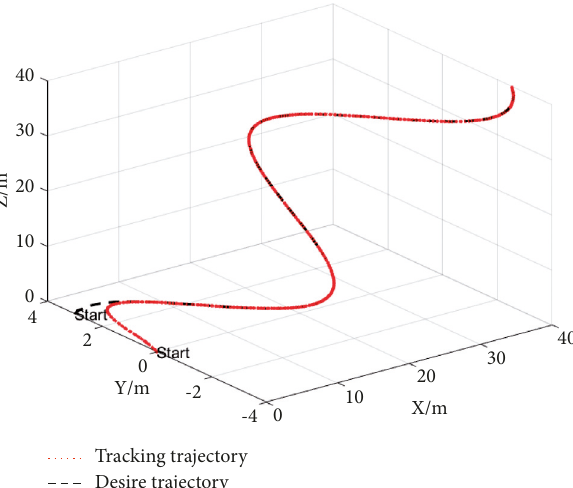
Figure 16: The curve of tracking error.